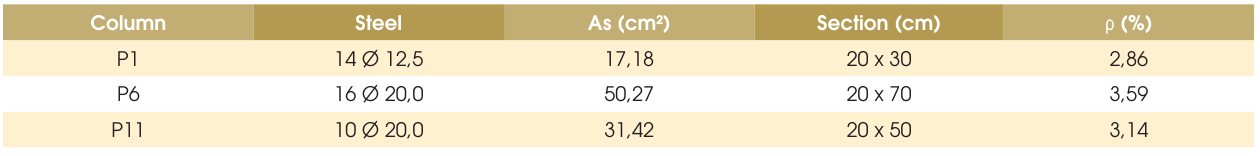
Table 1 – Dimensions and steel of columns studied for the 10-floor model